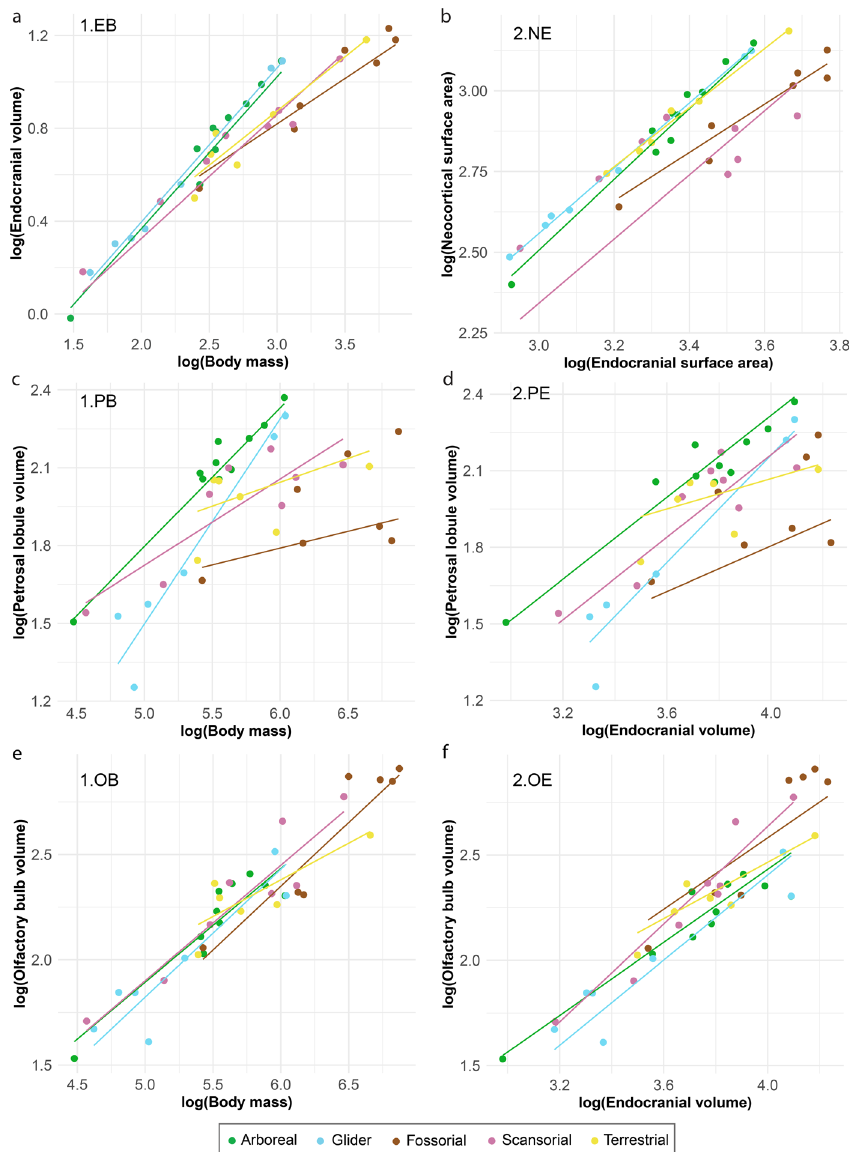
Fig. 3 Relationships between the brain, brain regions, and body size organized by locomotor behaviour in Sciuroidea. Phylogenetic corrected PGLS regressions of a 1.EB, Endocranial volume ~ Body mass + Locomotion * Body mass; b 2.NE, Neocortex surface area ~ Endocranial surface area + Locomotion; c 1.PB, Petrosal lobule volume ~ Body mass + Locomotion * Body mass; d 2.PE, Petrosal lobule volume ~ Endocranial volume +